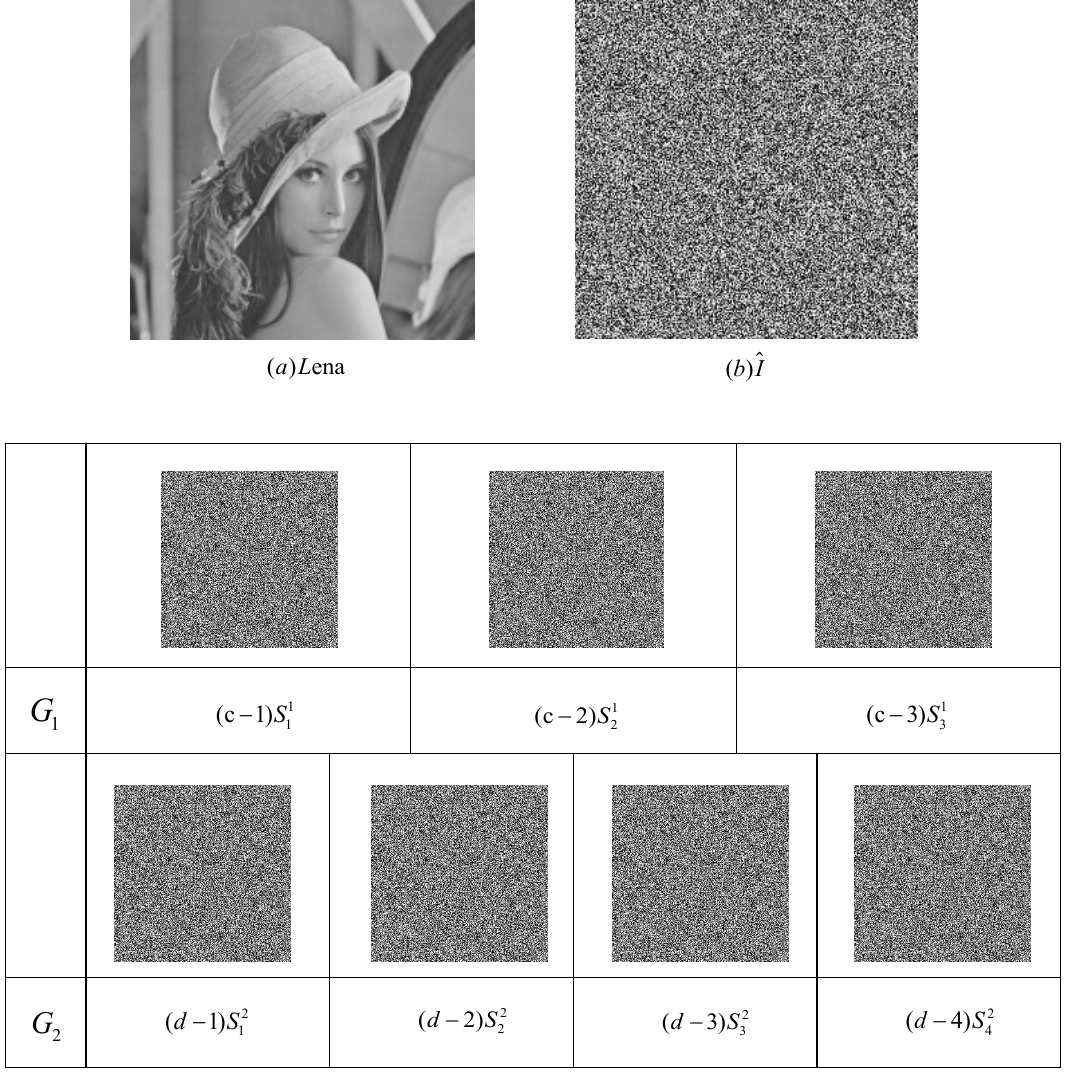
Figure 1. ( a ) the test secret image “Lena”, ( b ) the permuted secret image, ( c ) the generated shares sent to G 1 , ( d ) the generated shares sent to G 2